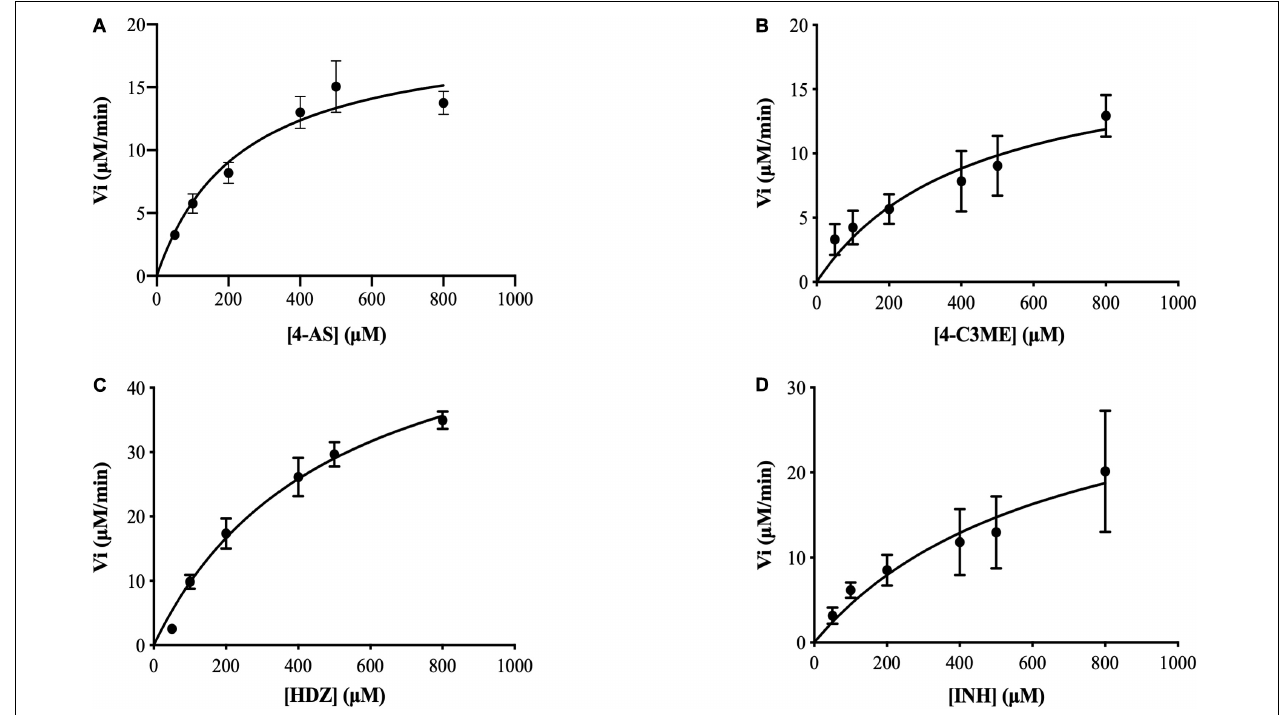
FIGURE 6 | Determination of the K m and V max values of (VIBVN)NAT. The activity of NAT was detected by the DTNB method. Michaelis–Menten plots for the calculation of K m and V max for the enzyme with (A) 4-AS, (B) 4-C3ME, (C) HDZ, and (D) INH as the substrate. The data are presented as the mean ± SD of three independent experiments. Error bars indicate SD values.